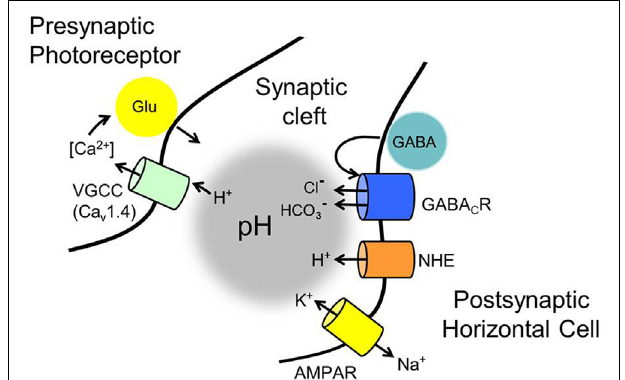
FIGURE 12 | Membrane mechanisms identified in the GABA-pH hybrid model of feedback that have roles in modulating the pH of the mammalian photoreceptor synaptic cleft. Standing as the foundation of the feedback mechanism are voltage-gated Ca V 1.4 channels in photoreceptors that ultimately regulate glutamate release. Notwithstanding ephaptic-coupled voltage changes of the cleft, never identified in mammalian retinas, regulation of the Ca V channels by surface charge screening due to cleft pH changes has proven to be a powerful modulator of glutamate release. Contributors to cleft pH implicated in the current review include: (1) tonic autaptic release and reception of GABA by horizontal cells (only mammalian horizontal cells appear to release GABA via a vesicular mechanism, but an alternate mechanism, reversed GABA uptake, operates in many vertebrates). (2) While GABA release is controlled by horizontal cell Ca V channels, evidence indicates that significant GABA levels are tonically present in the cleft, under light and dark-adapted conditions, and only change via membrane potential on longer time scales. (3) Tonic activation of ρ subunit containing GABARs provides HCO − 3 efflux, whose amplitude is regulated by the driving force determined by the horizontal cell membrane potential, which is influenced strongly by photoreceptor glutamate release onto horizontal cell AMPARs, and the equilibrium potential for HCO − 3 . (4) HCO − 3 efflux and depolarization-modulated proton extrusion via NHEs compete to change cleft pH. These steps result in the regulation of cone glutamate release in a manner dependent on horizontal cell V m and this underlies the surround inhibition and regulation of synaptic strength, the hallmarks of horizontal cell feedback to